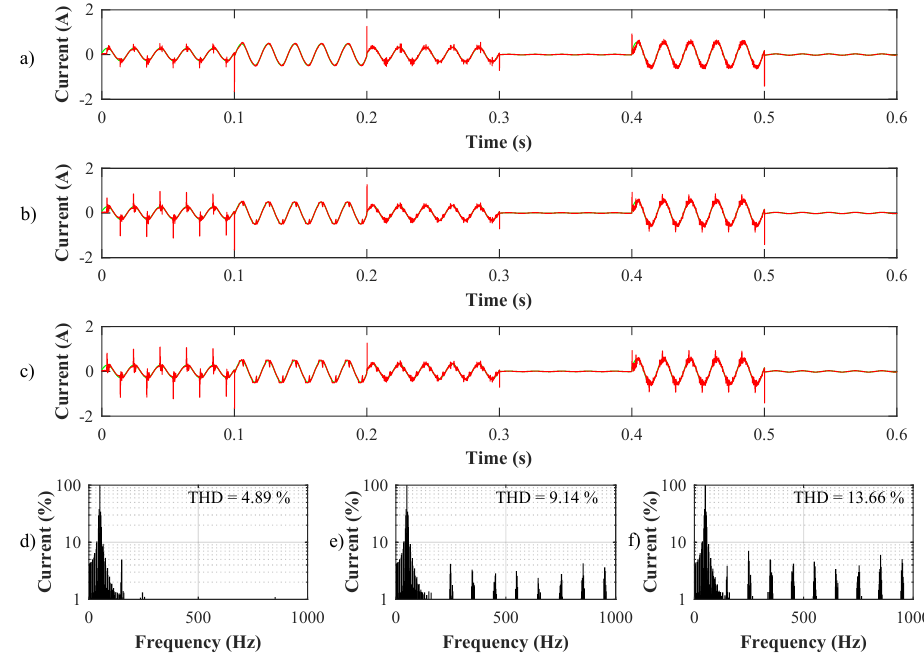
Figure 15. Influence of inverter delay on shape and THD after applying the RLS algorithm with a filter length of 2 and a forgetting factor of 0.999. ( a ) after applying a 50 µ s delay, ( b ) after applying a 150 µ s delay, ( c ) after applying a 200 µ s delay, ( d ) FFT after applying a 50 µ s delay, ( e ) FFT after applying a 150 µ s delay, and ( f ) FFT after applying a 200 µ s